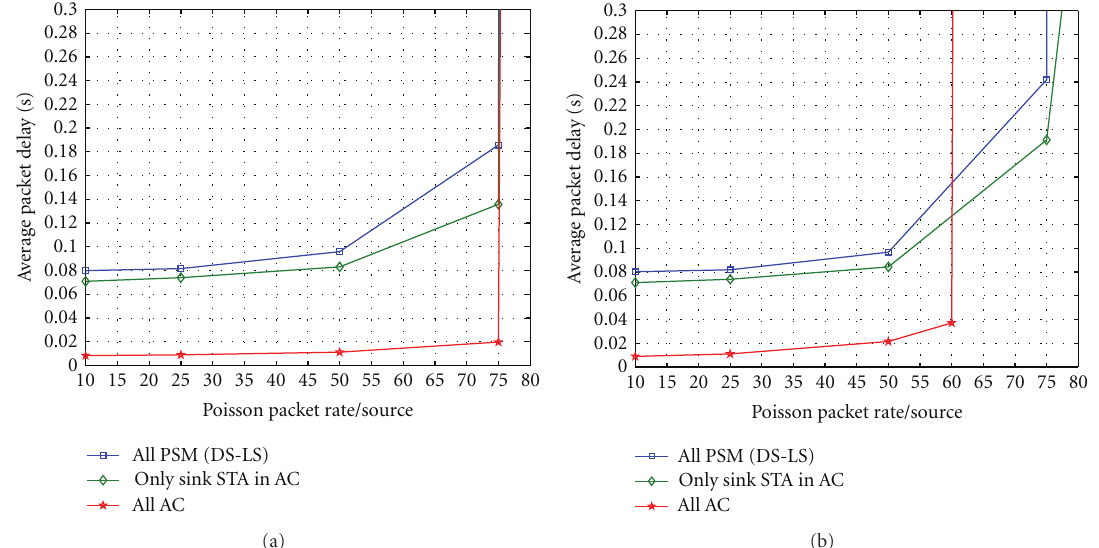
Figure 18: The average packet delay over 3 hop. (a) For Setup 1 (no hidden node) (b) For Setup 2 (hidden node exists). Hidden node has significant impact on active mode operation.